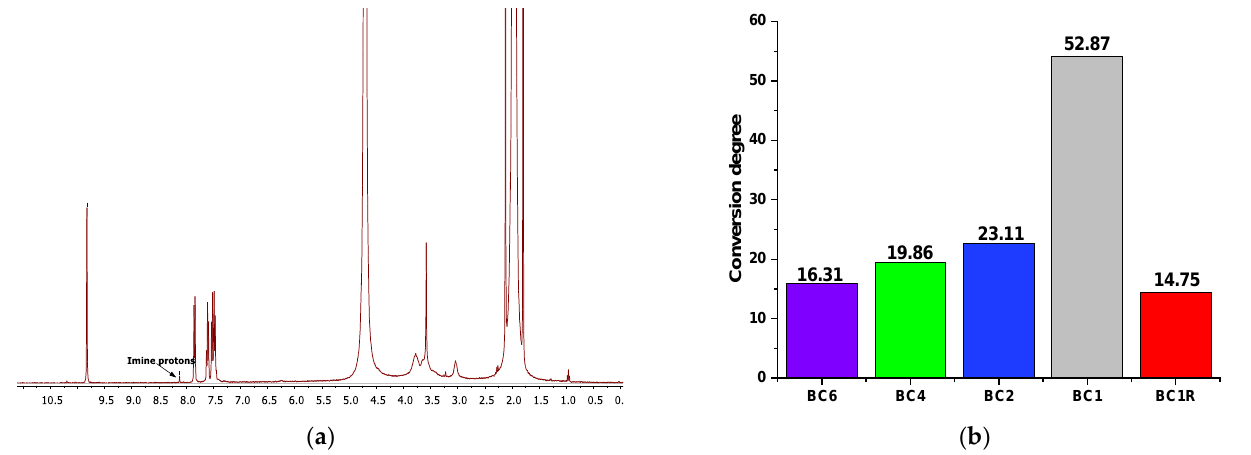
Figure 2. ( a ) Representative 1 H-NMR spectrum of BC1 in 1%AcOH in D 2 O. ( b ) Graphical representation of the conversion of amine groups of chitosan into imine units.